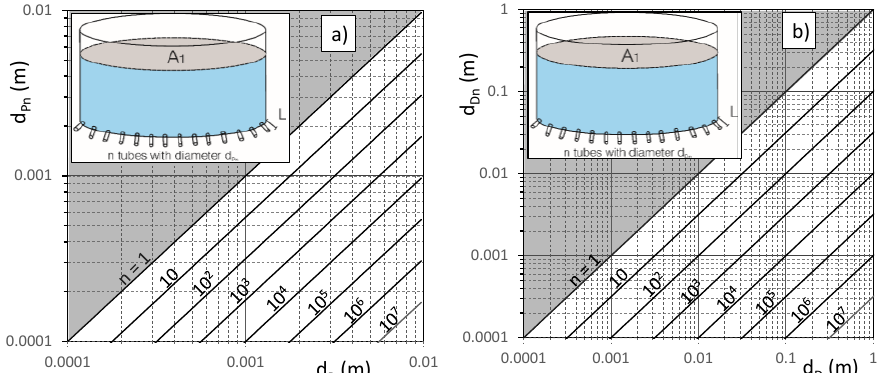
Figure 4. Number of tubes, n , with the same diameter ( d Pn ; d Dn ) required to replace a wider tube ( d P ; d D ) for a Poiseuille ( a ) and Darcy ( b ) reservoir.